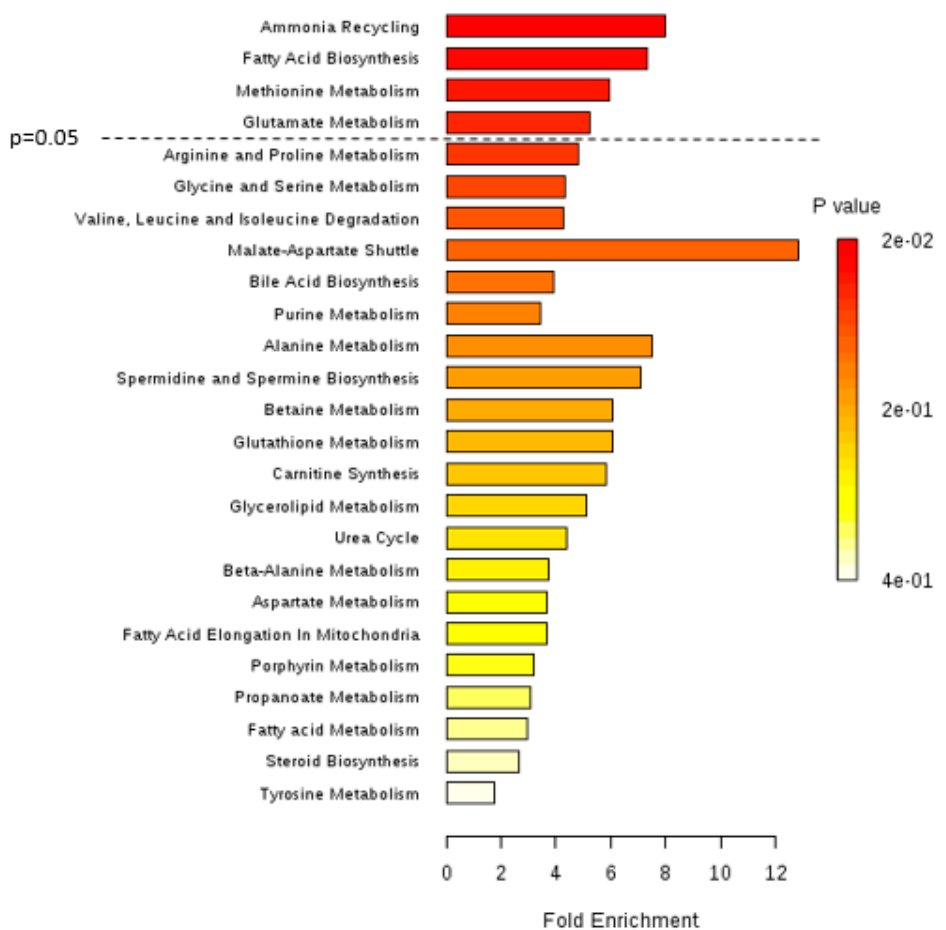
Figure 3. Summary plot for metabolite set enrichment analysis (MSEA) performed for the HG bladder cancer (BC) cell line (J82) versus the LG BC cell line (5637), where metabolite sets are ranked according